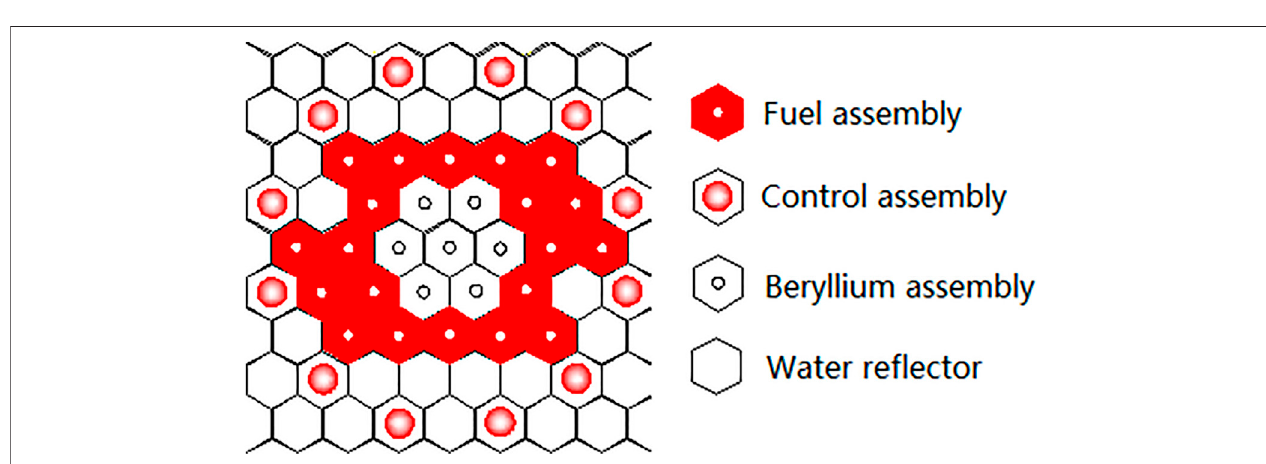
FIGURE 4 | Core arrangement of Scheme